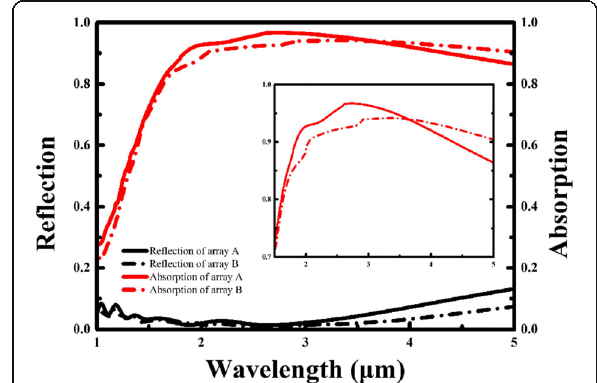
Fig. 8 Reflection and absorption of array A and array B